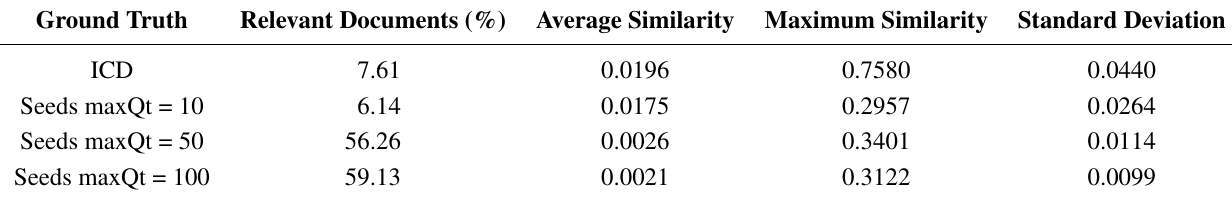
Table 5. Statistics on Heritrix